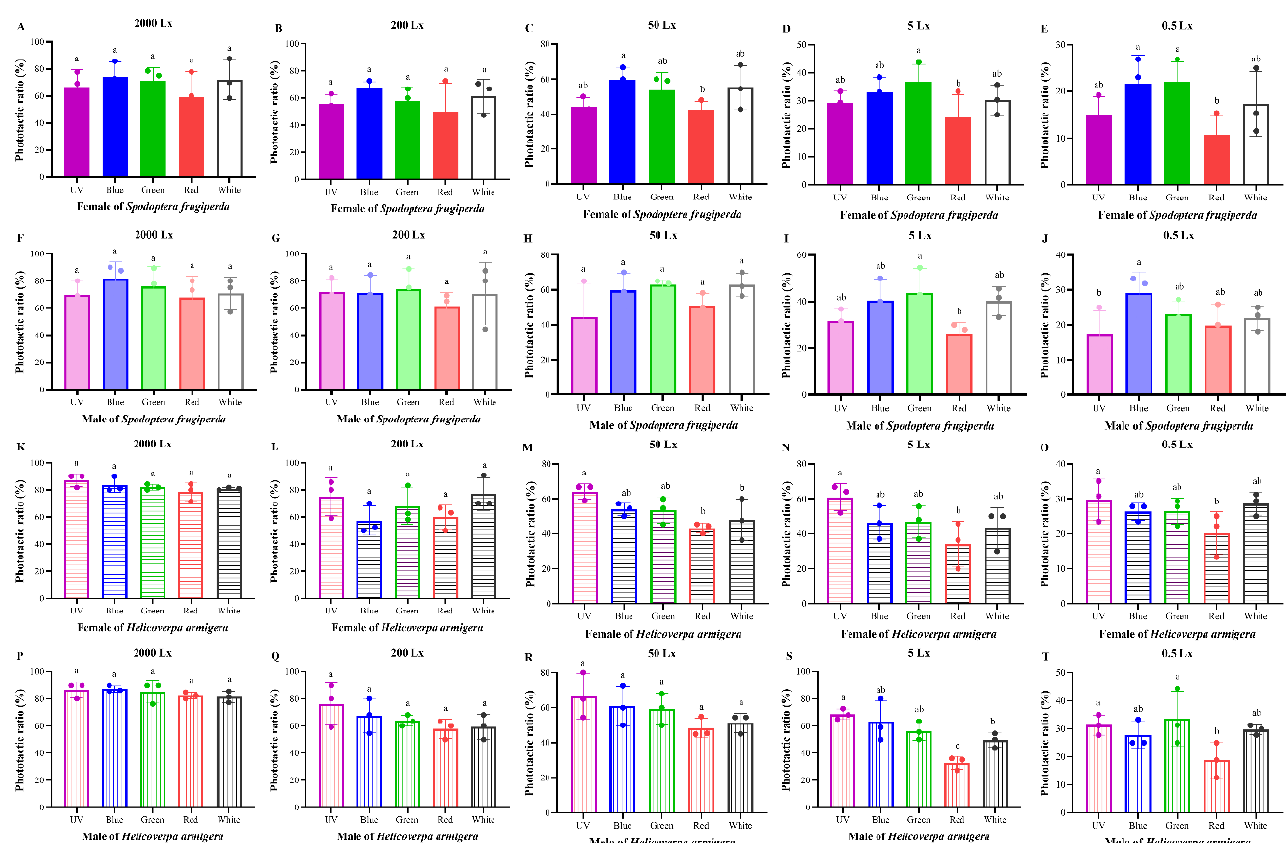
Figure 1. Phototactic rates of S. frugiperda and H. armigera to different wavelength lights. Data are mean ± SE. ( A – E ), phototactic ratios of female S. frugiperda to five lights under different light intensities (( A ) for 2000 lx; ( B ) for 200 lx; ( C ) for 50 lx; ( D ) for 5 lx; ( E ) for 0.5 lx). ( F – J ), phototactic ratios of male S. frugiperda to five lights under different light intensities (( F ) for 2000 lx; ( G ) for 200 lx; ( H ) for 50 lx; ( I ) for 5 lx; ( J ) for 0.5 lx). ( K – O ), phototactic ratios of female H. armigera to five lights under different light intensities (( K ) for 2000 lx; ( L ) for 200 lx; ( M ) for 50 lx; ( N ) for 5 lx; ( O ) for 0.5 lx). ( P – T ), phototactic ratios of male H. armigera to five lights under different light intensities (( P ) for 2000 lx; ( Q ) for 200 lx; ( R ) for 50 lx; ( S ) for 5 lx; ( T ) for 0.5 lx). Means with different letters are significantly different according to Dunnett’s test ( p < 0.05, ANOVA). UV, UV LED; Blue, blue LED; Green, green LED; Red, red LED; White, white LED.